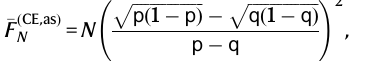
detection channel corresponding to Gaussian coarse-graining 35,37 , while in Methods we derive its form for lossy photonic interferometry with dark counts.